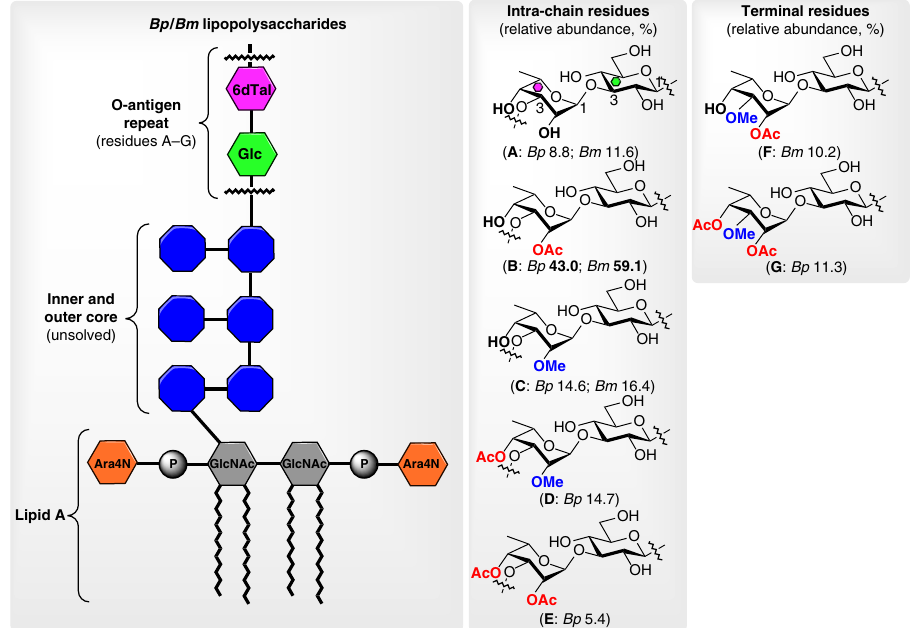
Fig. 1 Chemical structure of B. pseudomallei and B. mallei LPS antigens. Smooth LPS species consist of three major domains: the lipid A, the core, and the OAg repeat. The OAg is a linear heteropolymer featuring a disaccharide unit in an equimolar ratio of (1 → 3)-linked 6-deoxy- α - L -talopyranose and β - D -glucopyranose. Five internal (intrachain) and two terminal (non-reducing) disaccharide residues are present within the OAg. According to the species, they show different methylation and acetylation substitution patterns at the C2, C3, and C4 positions of the 6-deoxy- L -talose residue